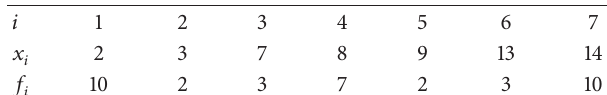
Table 1: Positive dataset given in [14].